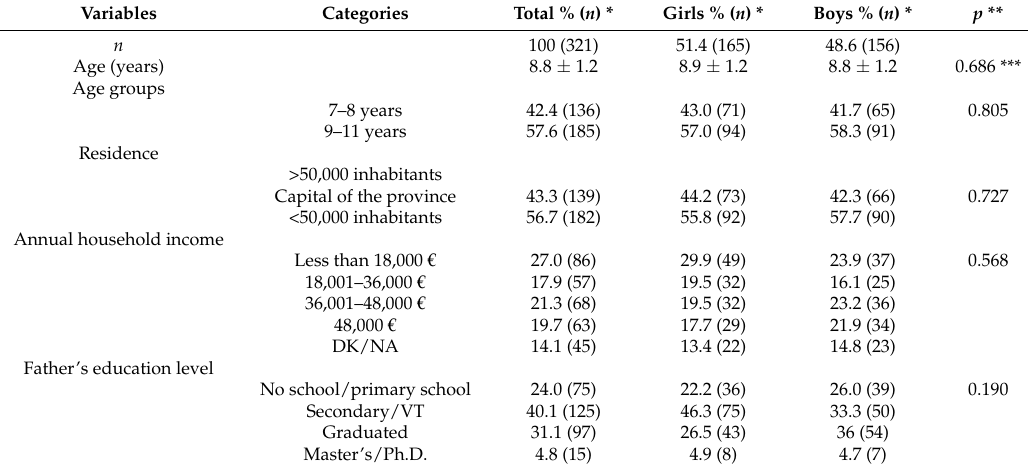
Table 2. Personal, demographic and socioeconomic data of a random sample of Spanish schoolchildren between 7 and 11 years